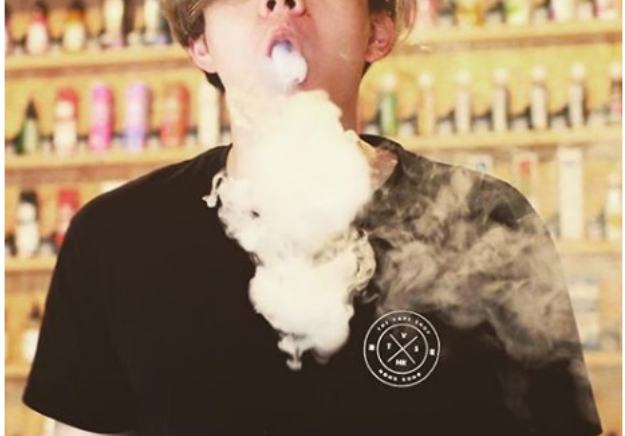
Figure 9. Example of male representation within the "behaviors and practices"